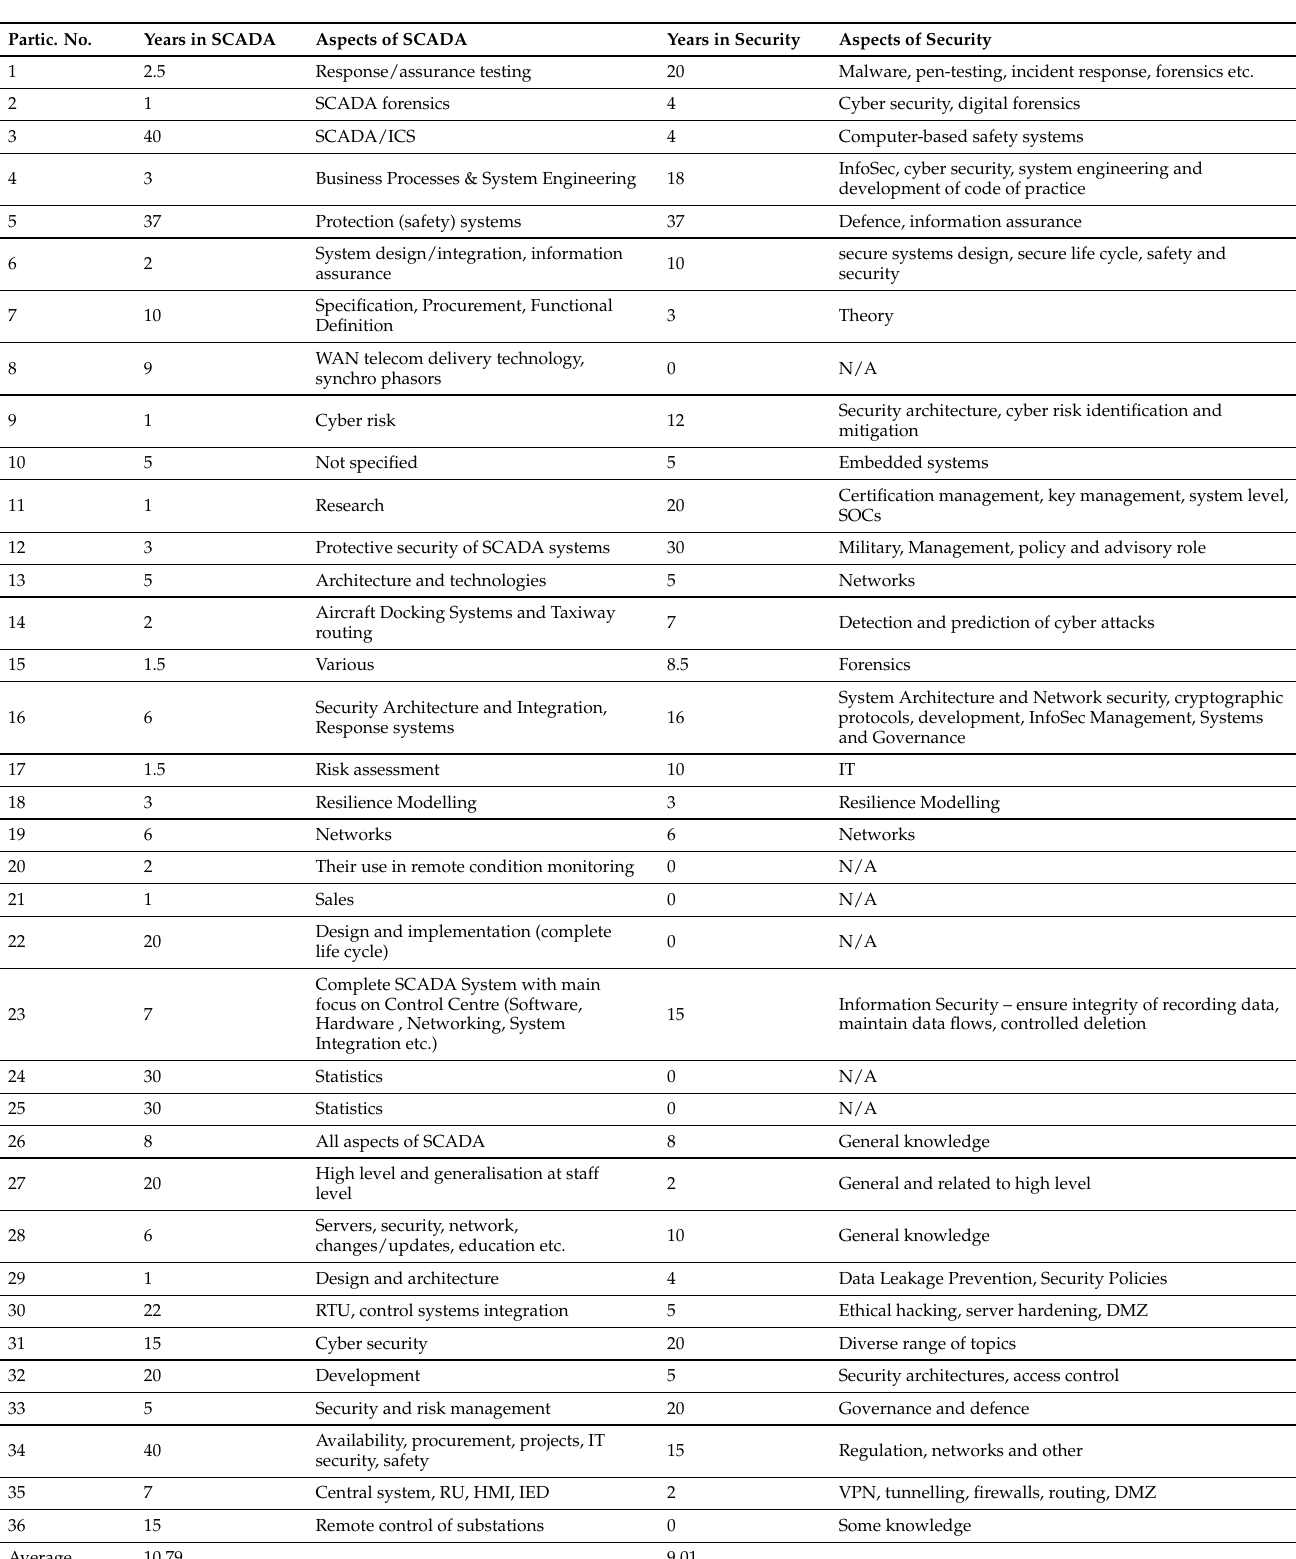
Table A2. Participants’ Profile. Expertise in SCADA and Cyber Security. Partic.